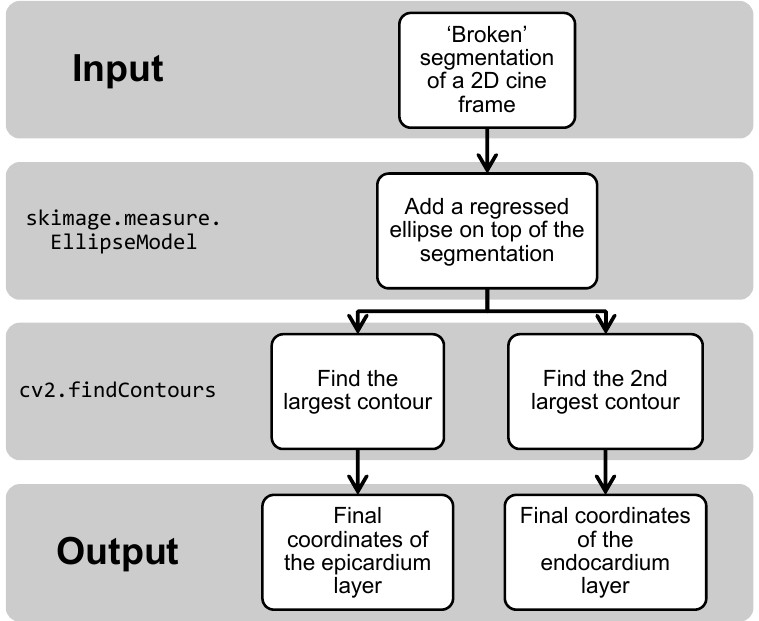
Figure 2. Flow chart of the post-processing workflow.